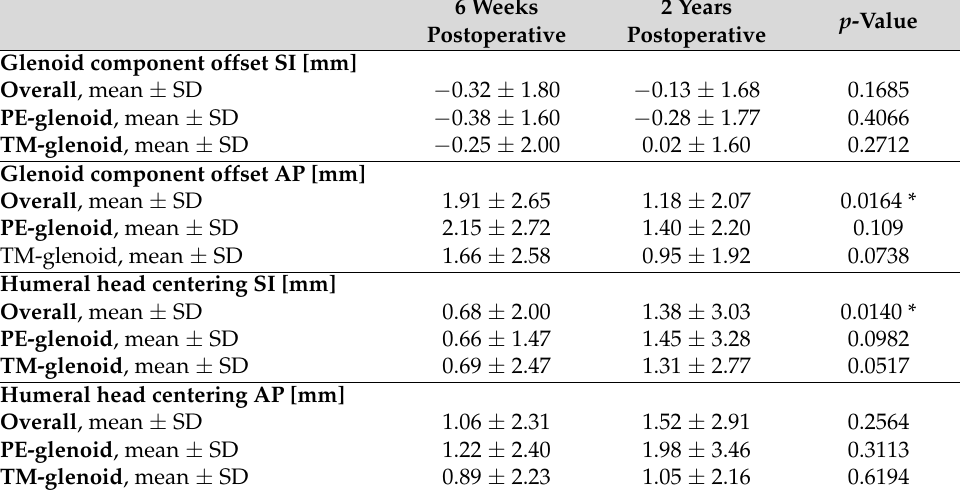
Table 2. Glenoid component offset superior–inferior (SI) and anterior–posterior (AP), and humeral head centering measurements SI and AP at six weeks and two years